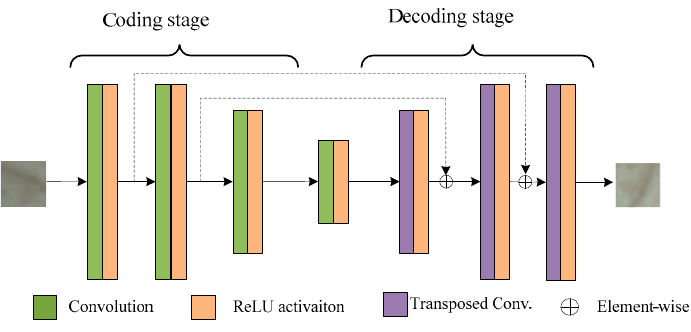
Figure 2. Convolutional auto-encoder mode.